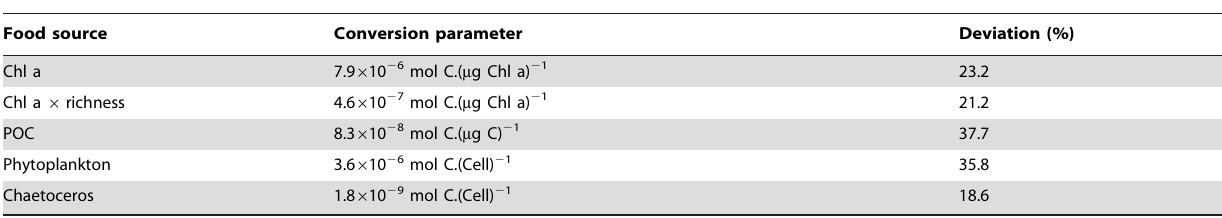
Table 2. Food proxy calibration and use in the model.